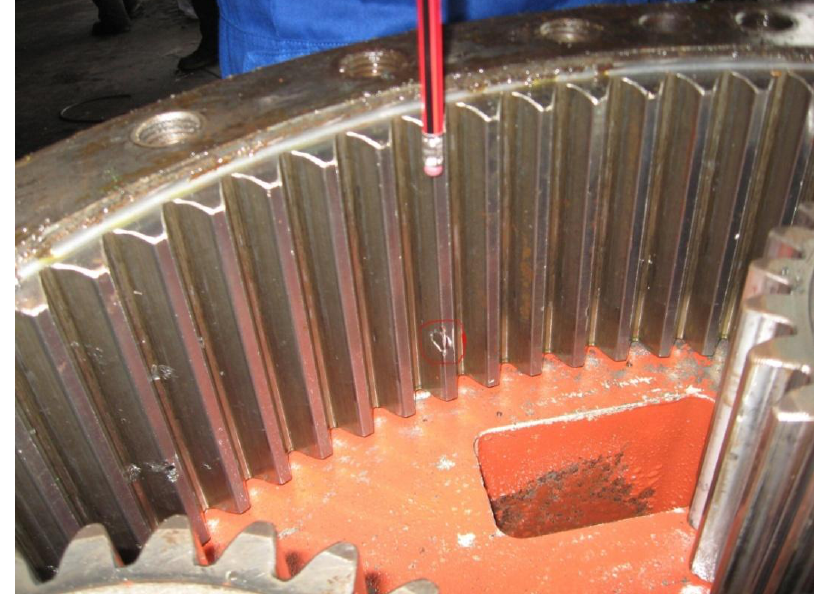
Figure 9. Picture of tooth-face abrasion and peel-off.